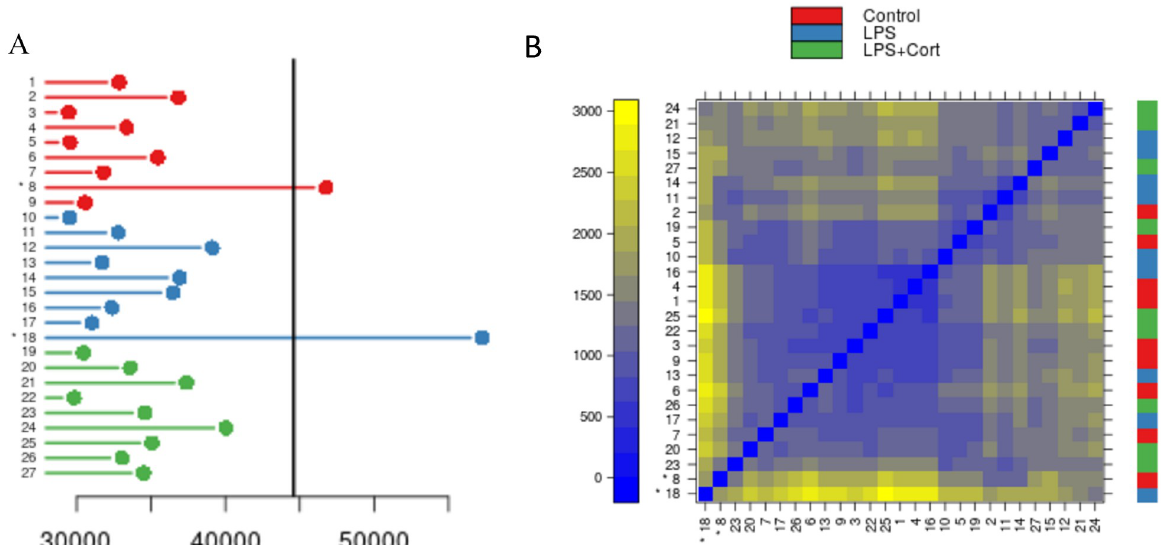
Fig 5. Identification of outliers by inter-array comparison. A. Sum of pairwise distances between the given array and all other arrays (N = 27, consisting of 3 biological replicates with 3 technical replicates each per treatment). The indicator line represents the point where the sum for a given array is significantly greater than the others with a p-value of < 0.05 according to one-way ANOVA with Tukey’s HSD test, corrected for multiple comparisons. Datasets 8 and 18 are outliers with p-values of 0.021 and < 0.001, respectively. B. Heatmap showing pairwise distances between arrays. These are sorted from least significant to most significant difference of sums on the y-axis and the reverse on the x-axis. The color bar on the right indicates the treatment group of the array shown on the x-axis, with red representing control, blue representing LPS alone, and green representing LPS with cortisol. Datasets 8 and 18 are present in the bottom left of the heatmap and are marked by asterisks.